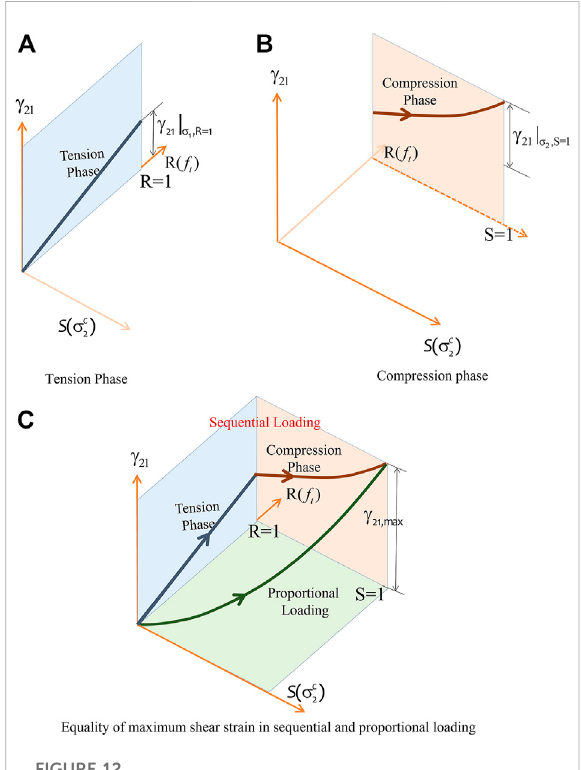
FIGURE 12 Schematic sketches showing maximum shear strain in load path. (A) Tension Phase. (B) Compression phase. (C) Equality of maximum shear strain in sequential and proportional